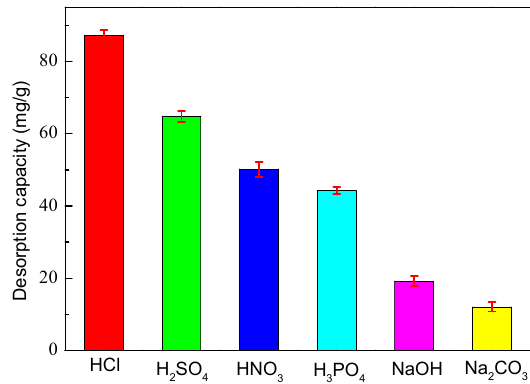
Figure 13. Effect of different desorption eluents on desorption capacity of LMT.